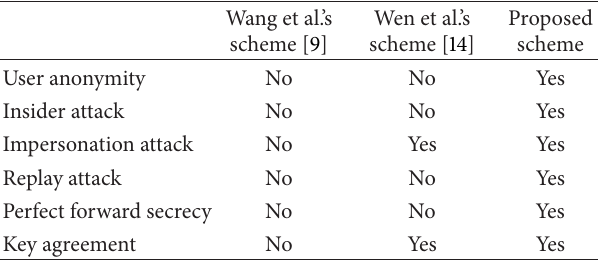
Table 1: Comparison of security